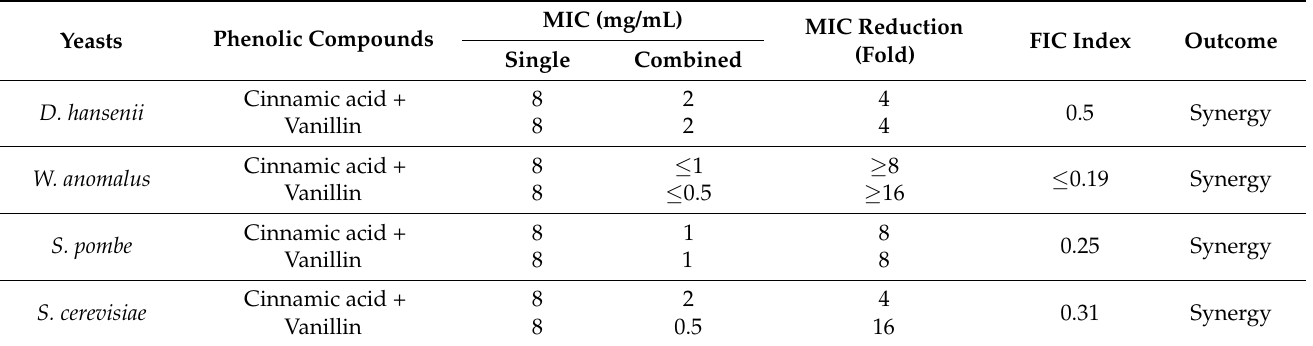
Table 5. Effect of combination of vanillin and cinnamic acid on biofilm formation of food spoilage yeasts.